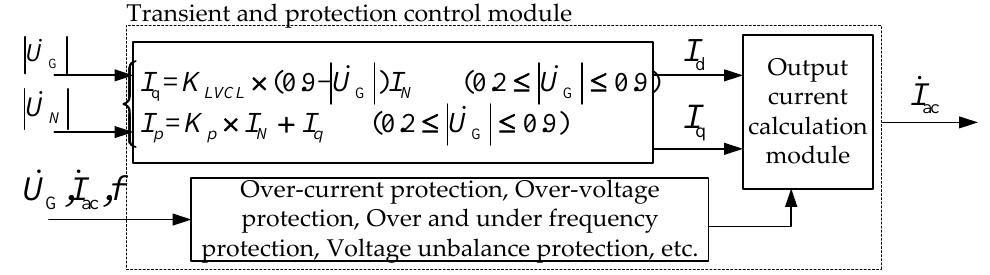
Figure 8. Block diagram of transient and protection control module.